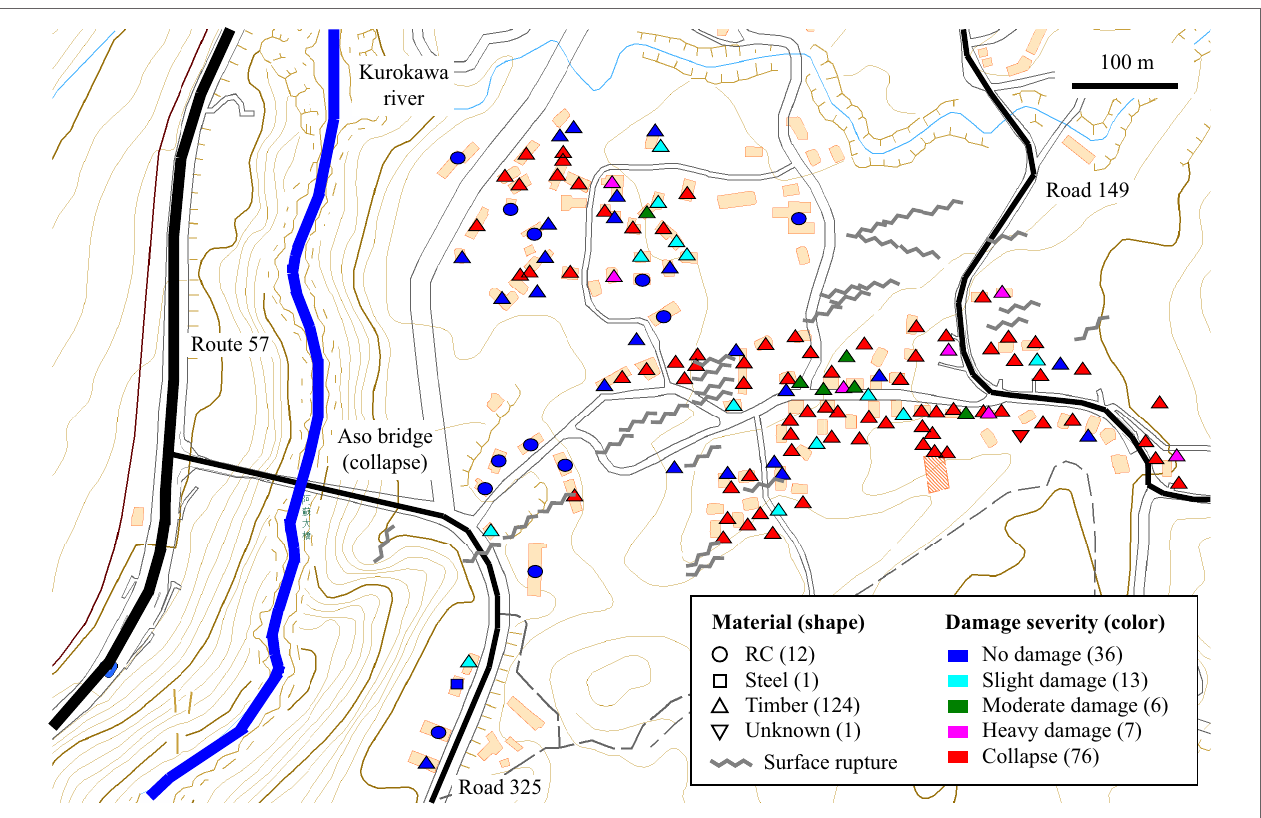
FigUre 18 | Damage survey results in the Kurokawa district of Minami aso village . The base map was obtained from the Geospatial Institute of